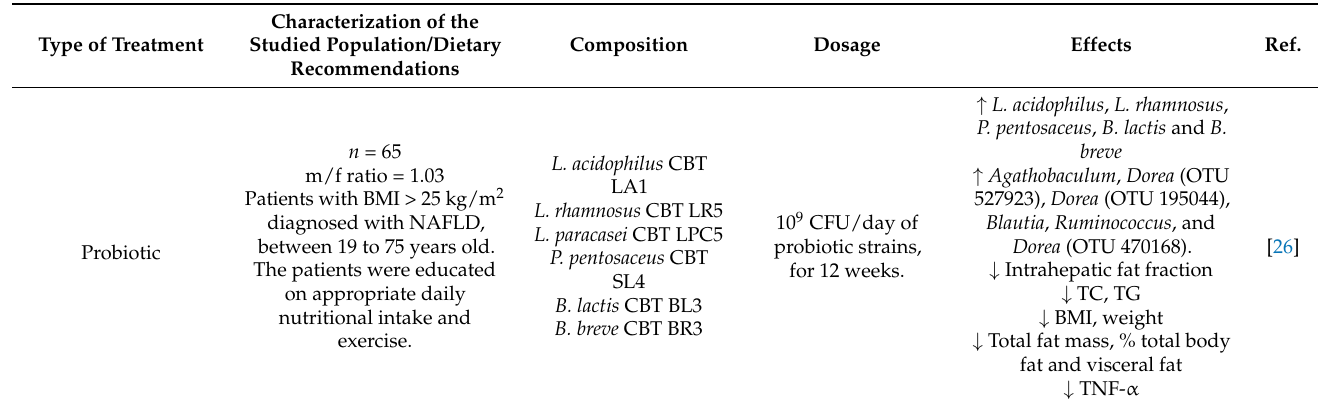
Table 1. Main effects of probiotic, prebiotic, and synbiotic treatments on patients with NAFLD. Characterization of the Type of Treatment Studied